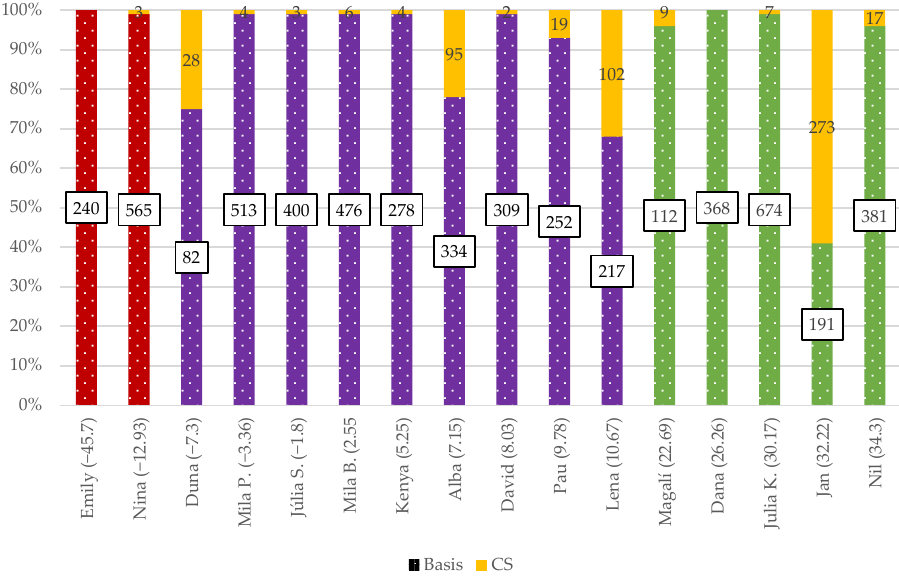
Figure 10. Basis and CS according to children’s fluency (child (FluencyD)).